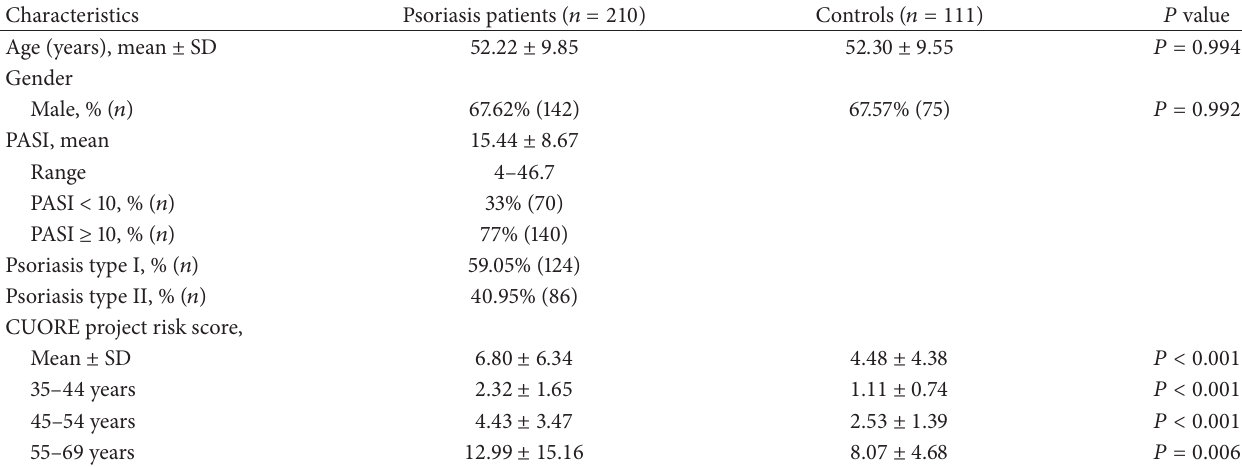
Table 1: Descriptive analysis of the demographic and clinical data of cases and controls.